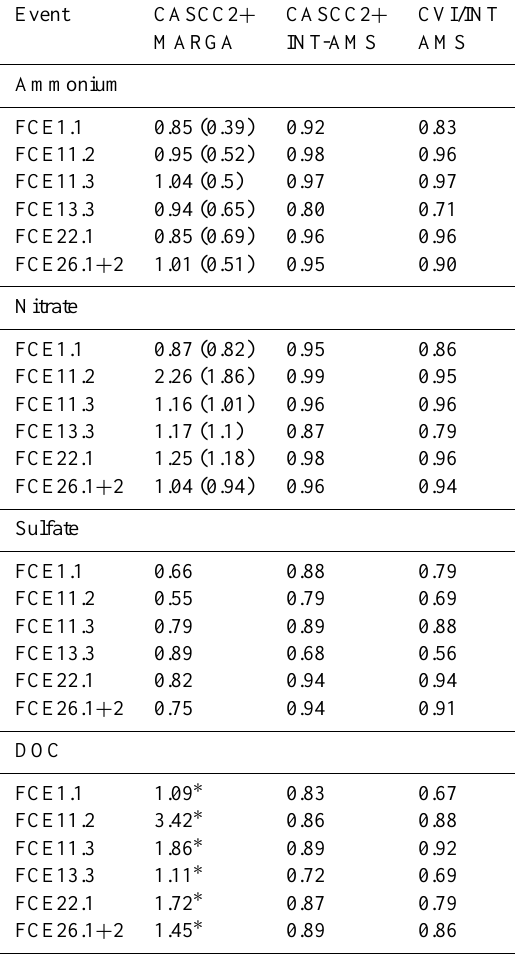
Table 5. Event means of upwind and in-cloud scavenging efficien- cies calculated from different approaches. Numbers in brackets in- clude both particulate and gaseous upwind concentrations, where available. See text for